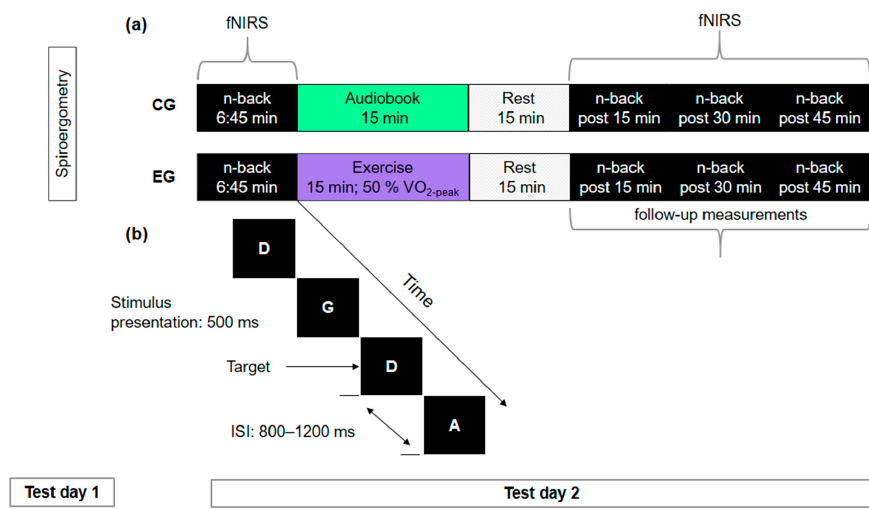
Figure 3. ( a ) Schematic illustration of the design and testing procedures consisting of two test days for the experimental (EG) and control group (CG). Using functional near-infrared spectroscopy (fNIRS), cortical hemodynamic activation was measured while participants performed the letter n-back task. ( b ) Schematic illustration of the 2-back condition of the n-back task. Stimulus presentation time was 500 ms, inter stimulus interval (ISI) was 800–1200 ms (on average 1000 ms). Participants were allowed to respond up to 2000 ms.